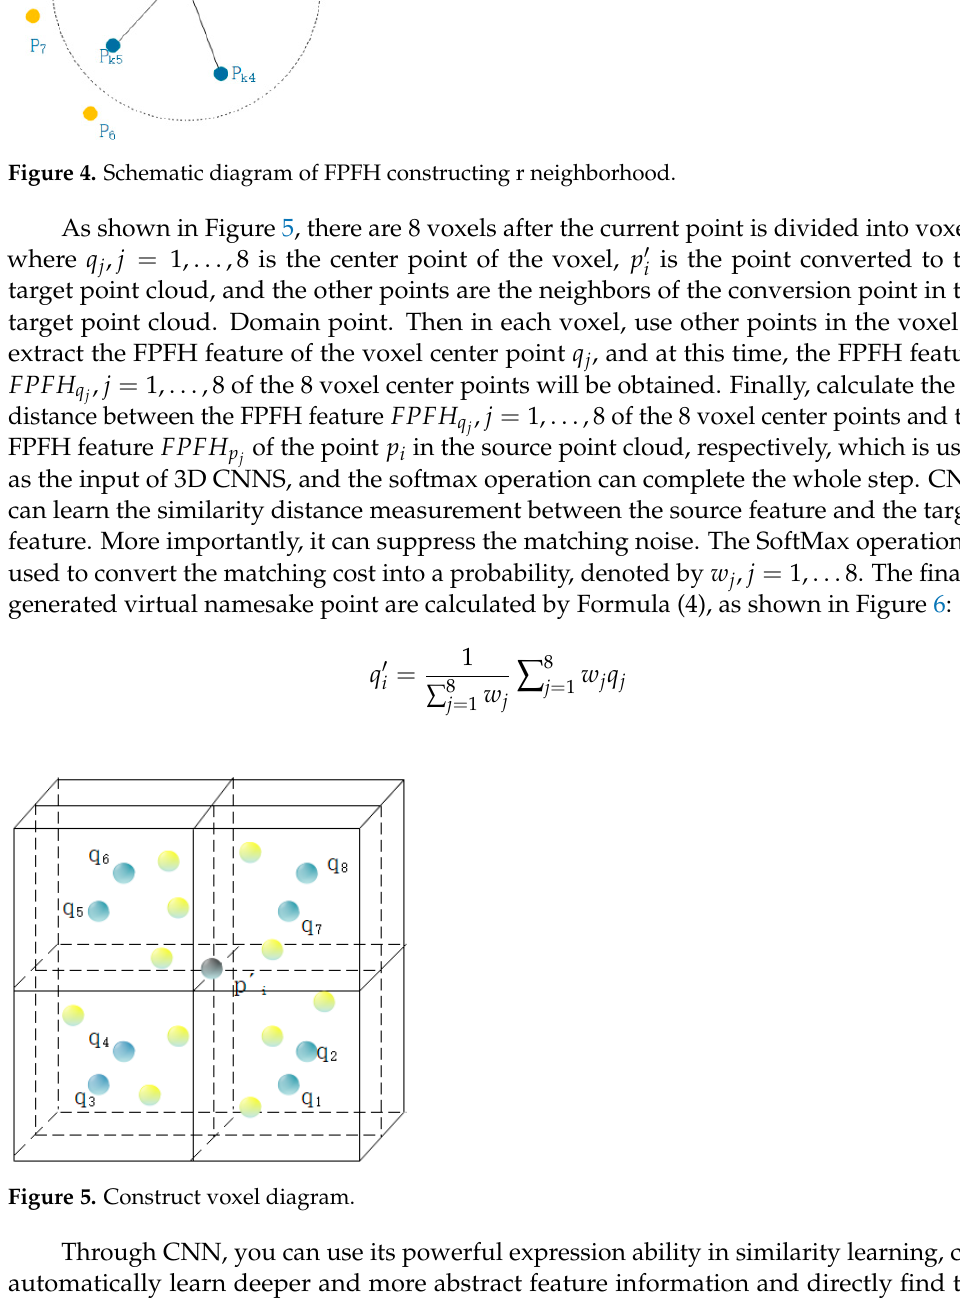
Figure 6. Virtual namesake point synthesis. Through CNN, you can use its powerful expression ability in similarity learning, can automatically learn deeper and more abstract feature information and directly find the corresponding virtual namesake point, avoiding the operation of finding the correspond- ing point in the existing point. Improve the accuracy of finding corresponding points, thereby improving the accuracy of point cloud matching. 3.2. Point Cloud Registration Algorithm Based on Virtual Namesake Point The entire improved point cloud registration algorithm process is similar to the clas- sic ICP algorithm. The biggest change is to use the virtual point search method proposed in Section 3.1. to replace the closest point in the classic ICP algorithm as the corresponding point process. The algorithm is summarized as follows: (1) First select two point cloud datasets P, Q with different accuracy, take the low-preci- sion point cloud P as the source point cloud, the relatively high-precision point cloud Q as the target point cloud and the points 𝑝 (cid:3036) , 𝑝 (cid:3036) ∈ 𝑅 (cid:2871) , 𝑖 = 1, … , 𝑁 (cid:3043) in the source point cloud as the candidate points. (2) Use the initial conversion matrix R, T to transform all points 𝑝 (cid:3036) in the source point cloud and convert all points 𝑝 (cid:3036) in the source point cloud to obtain the conversion points 𝑝 (cid:3036) ′, 𝑝 (cid:3036) ′ ∈ 𝑅 (cid:2871) , 𝑖 = 1, … , 𝑁 (cid:3043) . (3) Put all the obtained conversion points 𝑝 (cid:3036) ′ into the target point cloud Q , find the neighbor points of the conversion point in the target point cloud Q , set a threshold 𝑟 at this time, calculate the Euclidean distance 𝑑 between the conversion point and the nearest neighbor point in the target point cloud, compare the calculated distance with the threshold. If it is greater than the threshold, it indicates that the conversion point